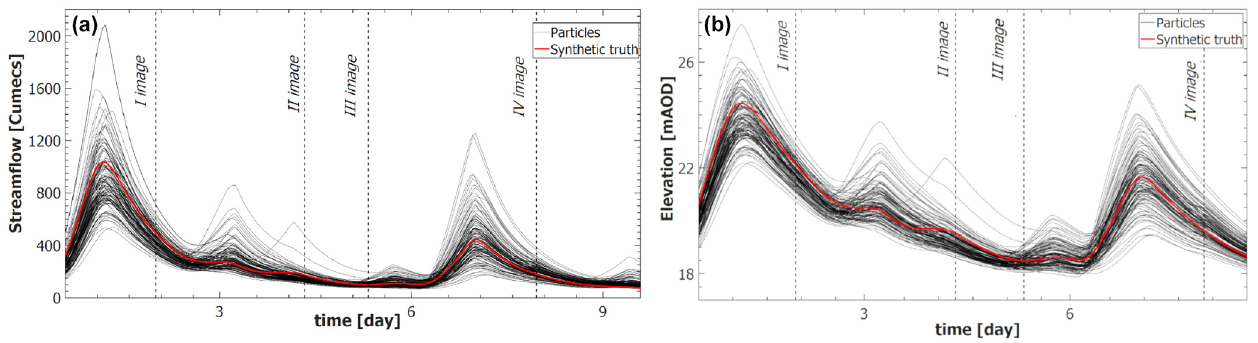
Figure 6. Streamflow time series (a) and water elevation time series (b) at the gauge station in Bewdley. Black lines represent the 128 particles while the red line corresponds to the synthetic